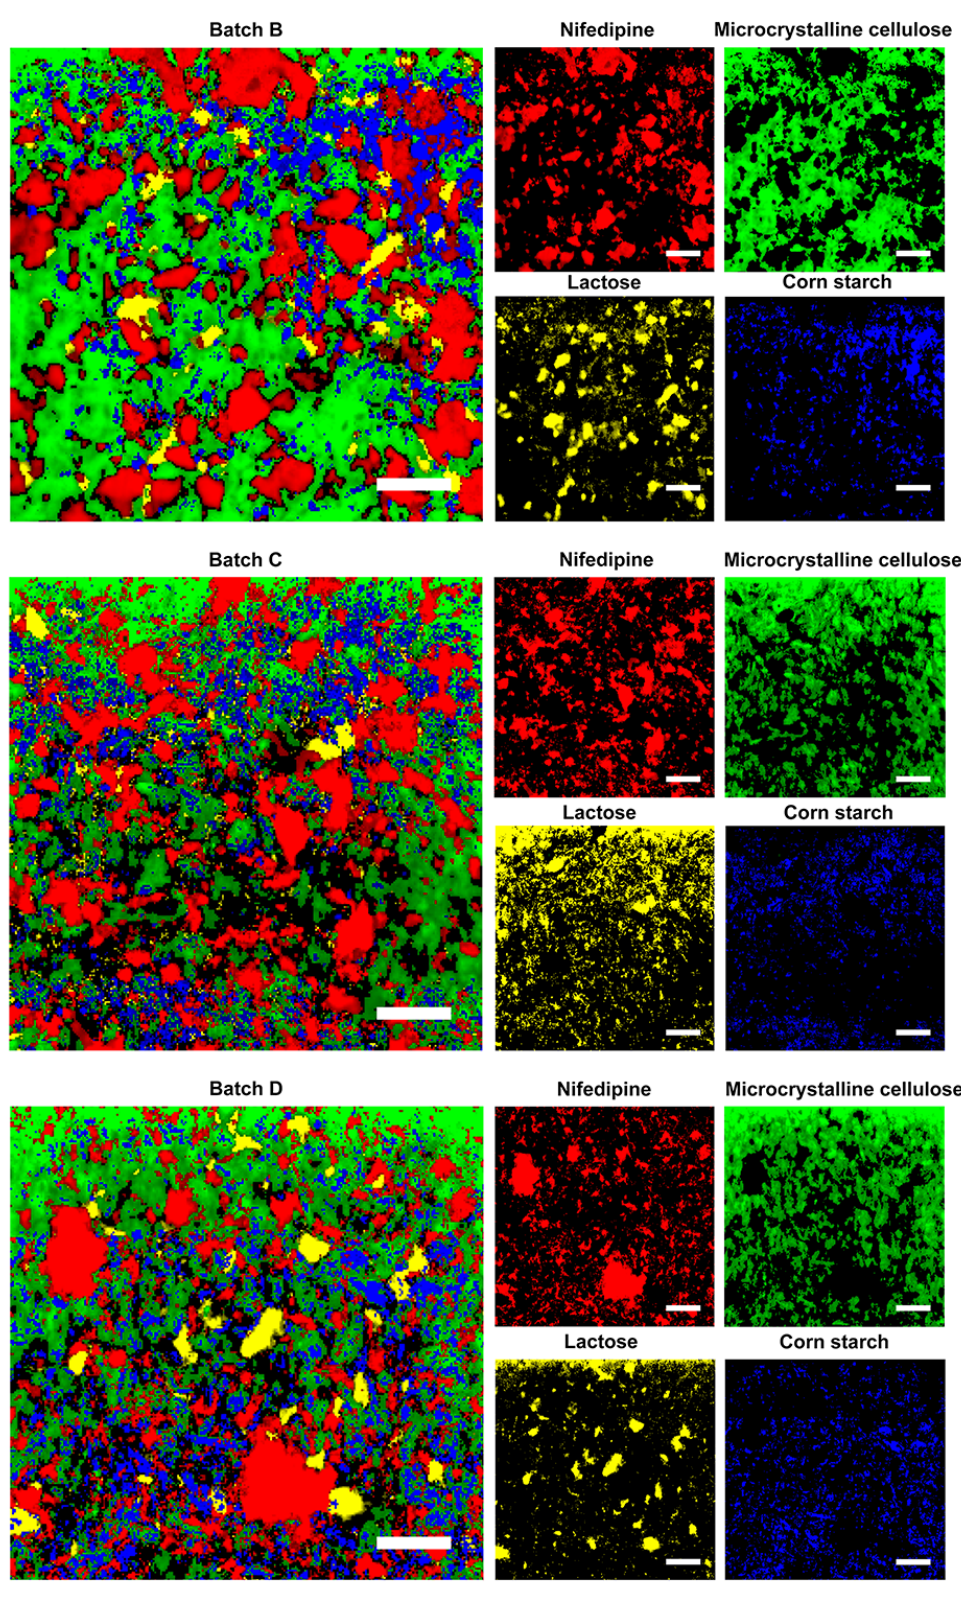
Figure 3. Raman mapping of the generic preparations, and distributions of nifedipine, microcrys- talline cellulose, lactose, and corn starch. Scale bar is 200 μ m. Table 5. Particle size of nifedipine in prepared tablets and Adalat ® -L.